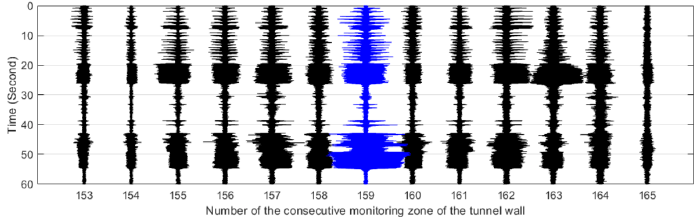
Figure 11. Distributed vibration responses of 13 consecutive monitoring zones under the perturbation of position P1.